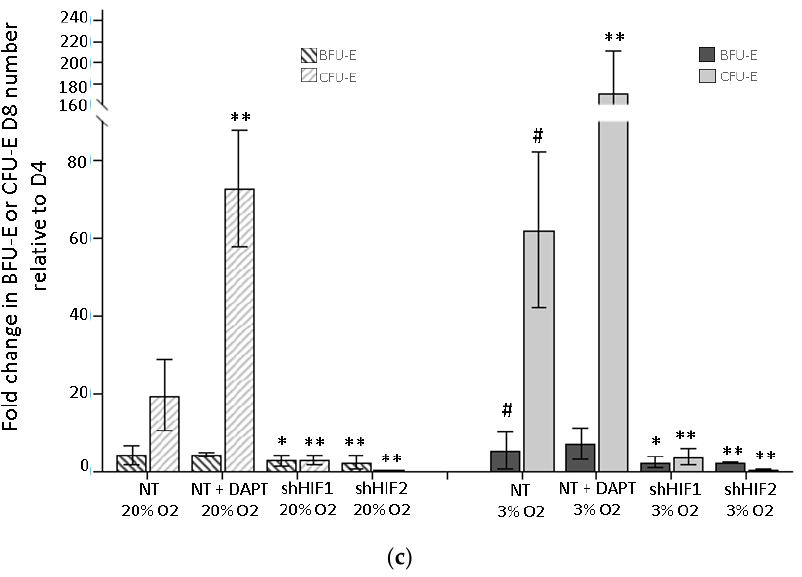
Figure 3. Production of erythroid progenitor. Non-transduced CD34 + cells in presence or absence of Notch γ -secretase inhibitor DAPT as well as transduced CD34 + cells with shHIF1α or with shHIF2α were grown in erythroid medium for 8 days at 20% and at 3% O 2 . The numbers of burst-forming unit erythroids (BFU-E) and colony-forming unit erythroids (CFU-E) were estimated after 4 ( a ) and 8 days of culture ( b ). Bars represent average values of total number of BFU-E and CFU-E obtained at Day 4 and Day 8 of culture. ( c ) The values show average fold change in BFU-E or CFU-E Day 8 number relative to Day 4. Data are presented as mean ± SD of seven independent experiments. Asterisks indicate a significant difference with respect to NT condition, at p < 0.05 (*), p < 0.01 (**); hashtags indicate a significant difference with respect to 20% O 2 condition, p < 0.05 (#), p < 0.01 (##), Mann–Whitney test. NT, non-transduced CD34 + cells; D, day of culture.